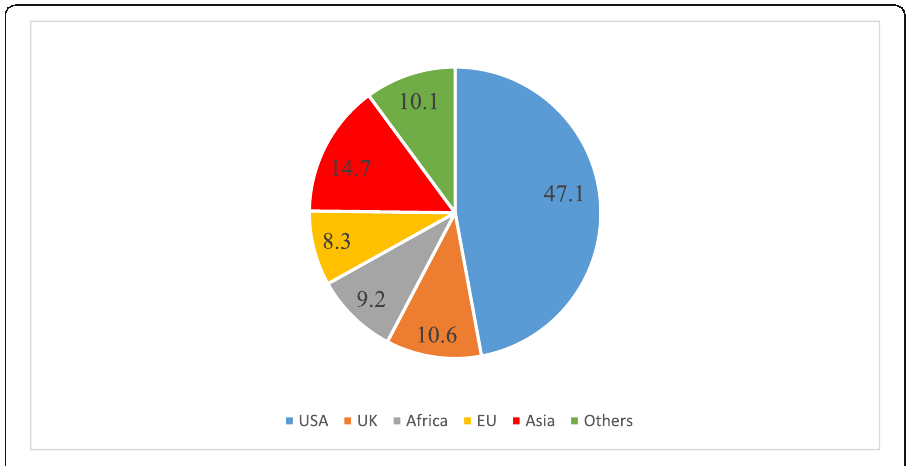
Fig. 3 Sources of remittance inflows to Kenya in 2017. Source: World Bank Migration and Remittances